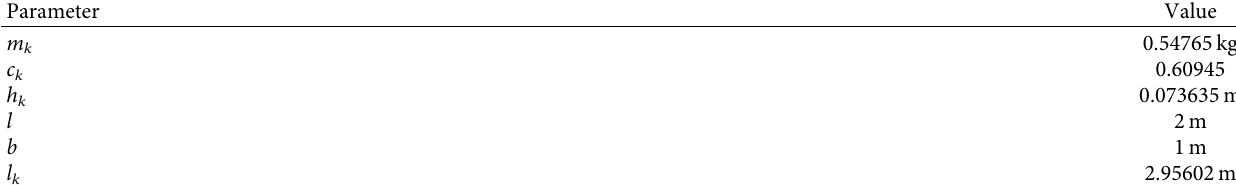
Table 7: Relevant parameters of the pendulum model of the 2 m long ∗ 1m wide spray tank.